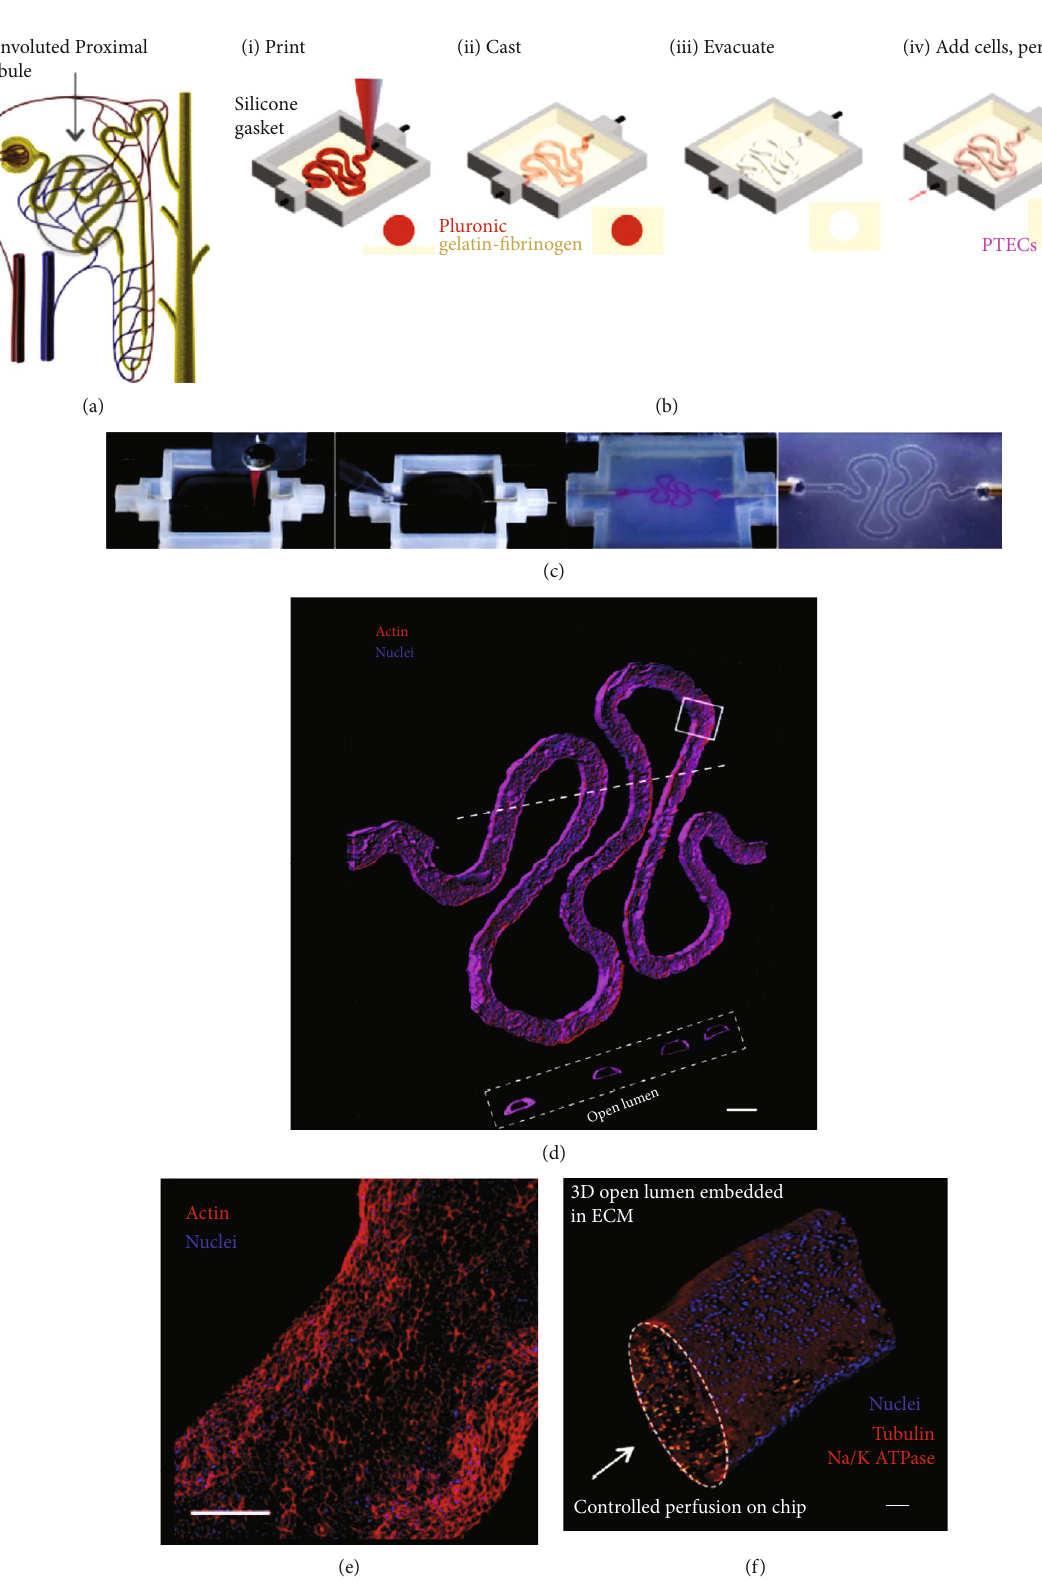
Figure 7: 3D convoluted renal proximal tubule on a chip. (a) Schematic of a nephron highlighting the convoluted proximal tubule; (b, c) corresponding schematics and images of di ff erent steps in the fabrication of 3D convoluted, perusable proximal tubules; (d – f) a 3D rendering of the printed convoluted proximal tubule acquired by confocal microscopy. Reproduced (or adapted) with permission [47], ©2016,